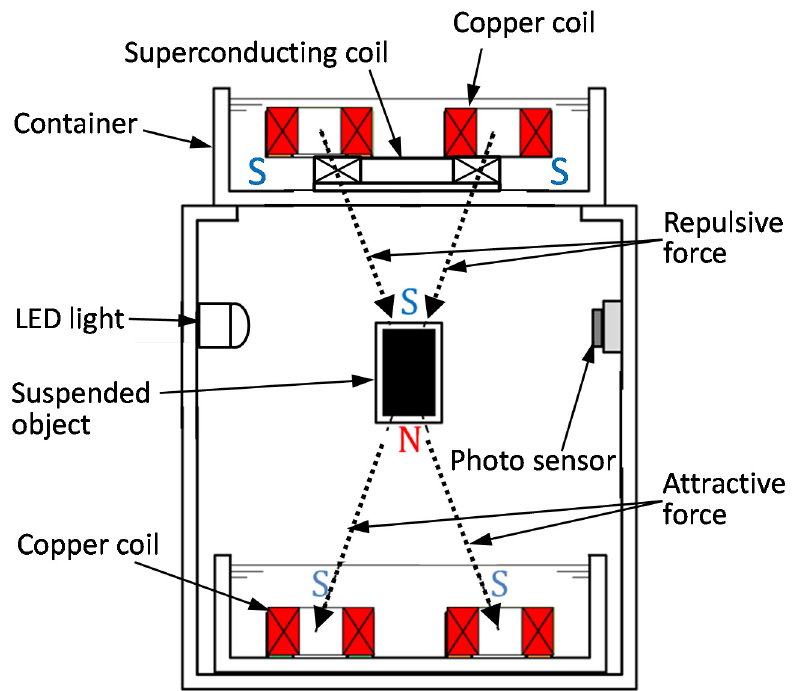
Figure 10. Schematic illustration of control force applied to suspended object.